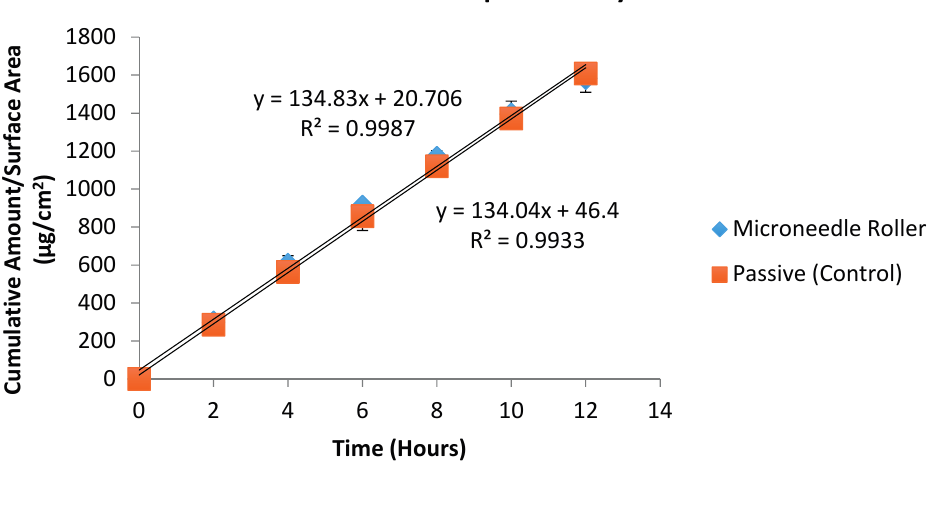
Figure 5. In vitro transdermal permeation of passive and microneedle-facilitated pramipexole dihydrochloride after microneedle roller application across porcine ear skin (500 μ m length, 540 per square centimeter